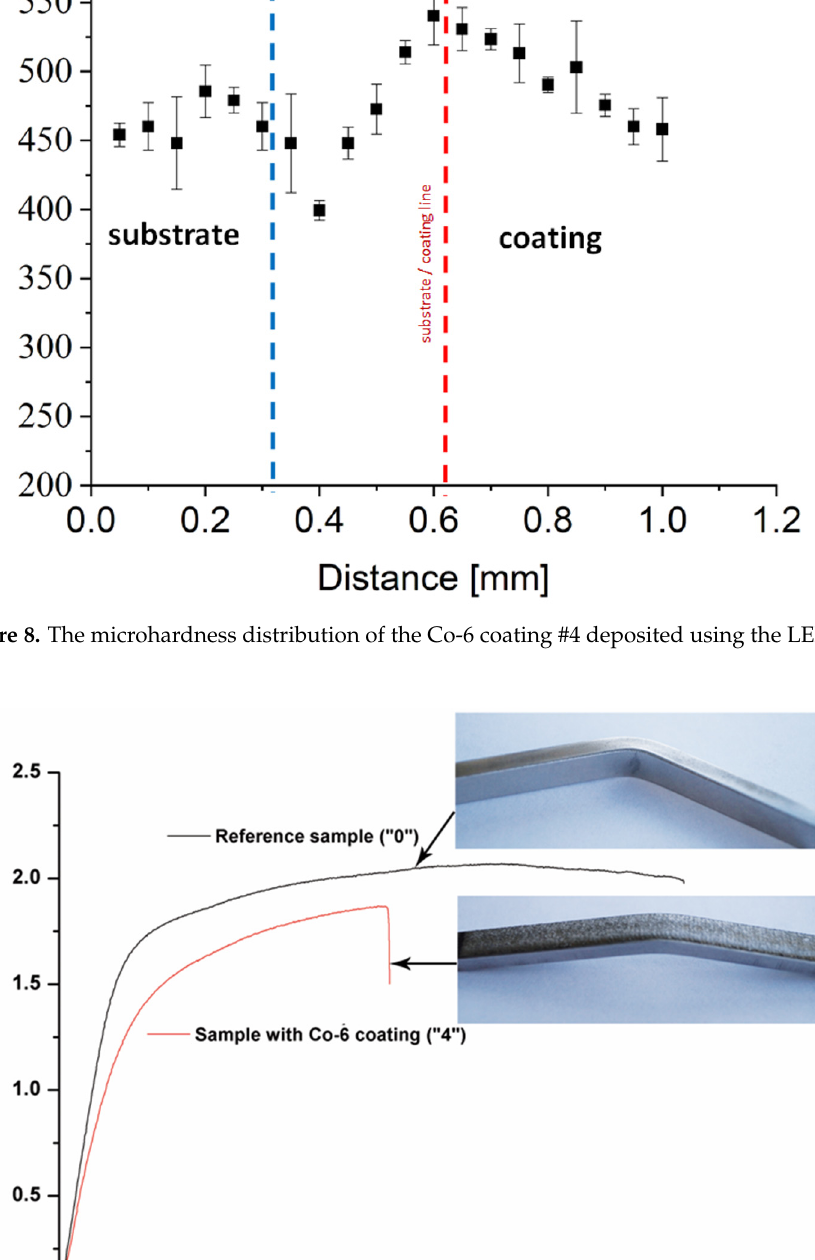
Table 2. The results of static bending test.